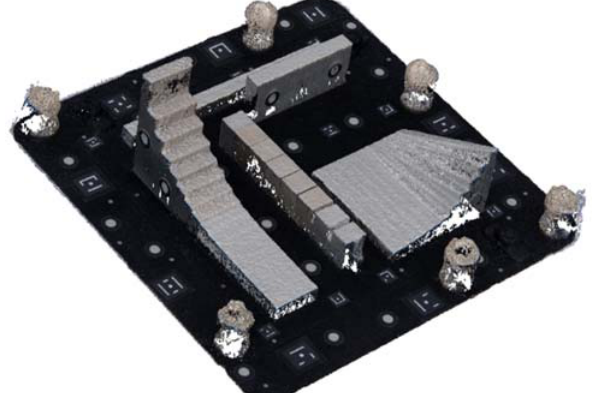
Figure 9. 3D point cloud produced by PhotoScan from the improved SfM procedure.